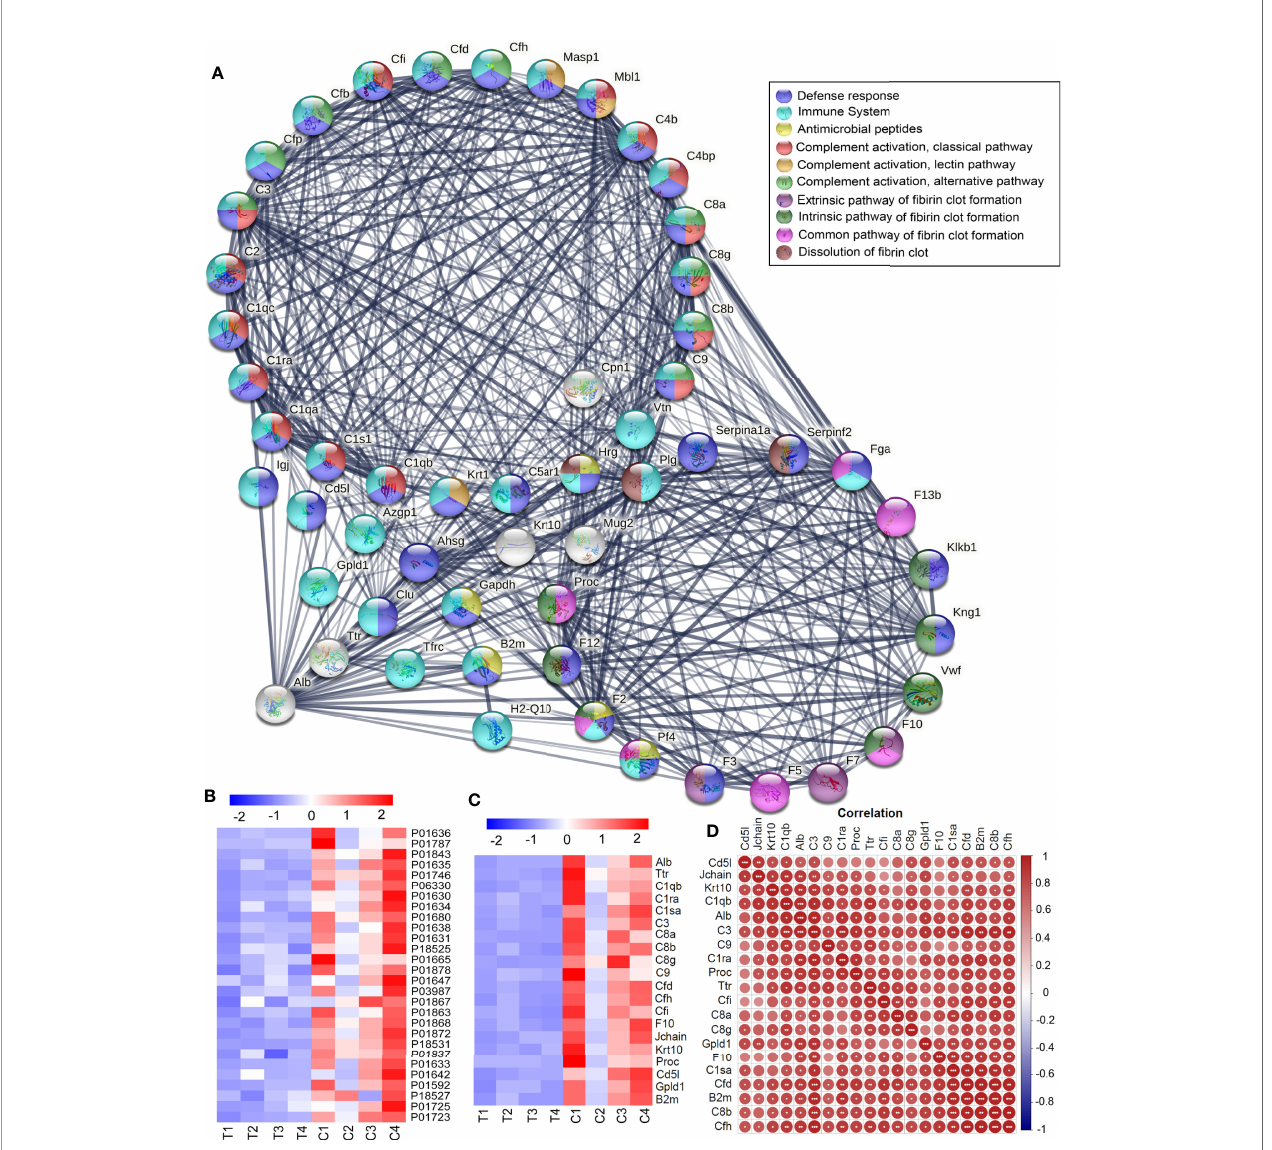
FIGURE 4 | Downregulated DEPs in Complement and coagulation cascades. (A) The downregulated DEPs in the Complement cascade covered all three complement activation pathways: alternative pathway, classical pathway, and lectin pathway. The blood coagulation pathways were downregulated, including common pathway, intrinsic pathway, and extrinsic pathway, and anticoagulation and fi brinolysis factors were also downregulated, such as Plg, Serpinf2, Serpina10, Proc, and Hrg. Of these down regulated proteins, 32 were related to the immune system, including complement components and 4 antimicrobial peptides Hrg, F2, Pf4, and B2m, and most of them were involved in defense response. (B) A large number of immunoglobulins were downregulated in thyrotoxicosis mice. (C) The correlation analysis was carried out for Alb and Trf and some DEPs in complement and coagulation cascades, it showed that Alb was positively correlated with those DEPs in complement and coagulation cascades. Red is positive correlation, correlation signi fi cance: * p <0.05; ** p <0.01; *** p